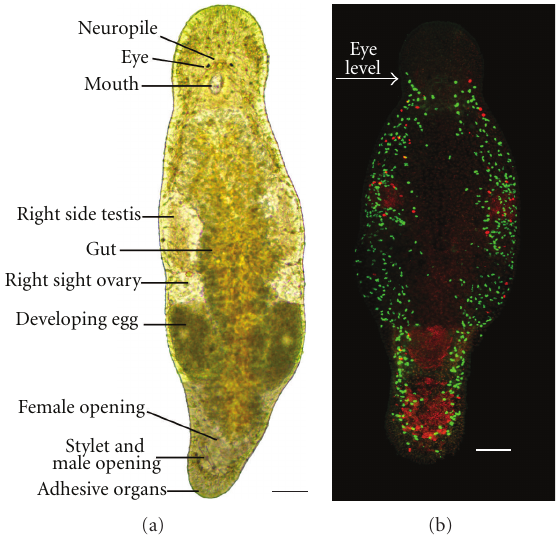
Figure 2: Macrostomum lignano as a model organism. (a) Bright field image of a living specimen. (b) Confocal projection of BrdU and phospho-histone H3 immunostaining after 30 minutes BrdU pulse in an adult worm (green: S-phase cells, red: mitotic cells). Scalebar 100 μ